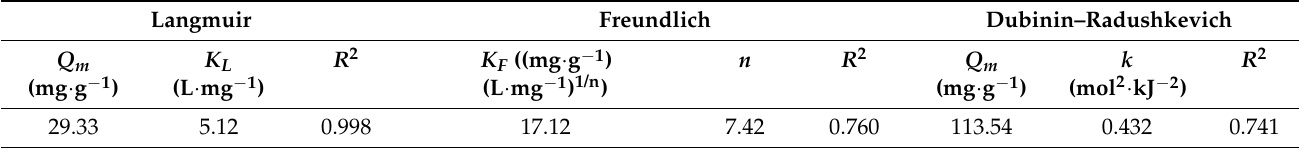
Table 9. Isothermal constants for the adsorption of lead ions on pristine slag.